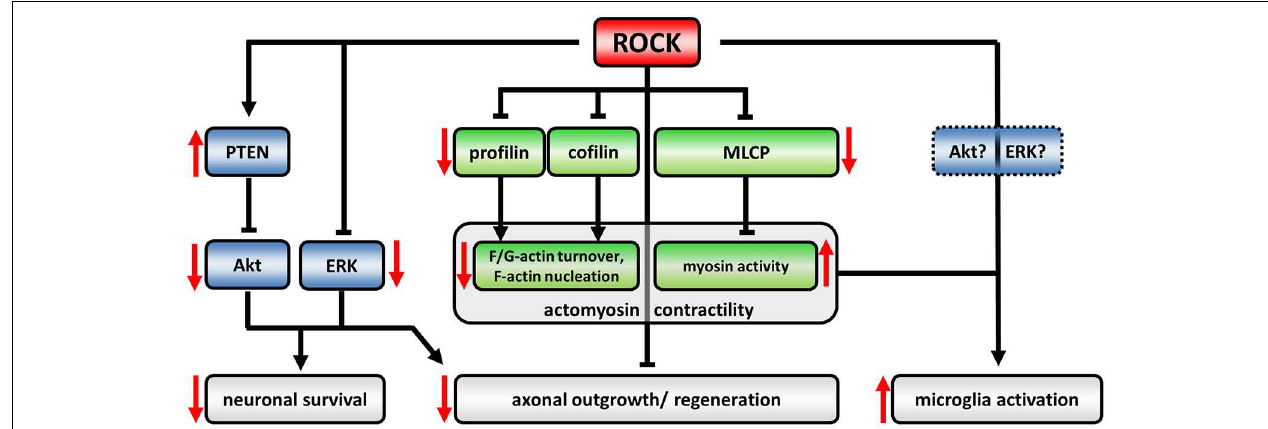
FIGURE 1 | The ROCK-pathway in neurons and microglia. The regulatory network downstream of ROCK is defined by activating (arrows) or inactivating (blunted arrows) interactions. Induction of ROCK-activity leads to an up- or down-regulation of downstream targets, respectively (effects of upregulated ROCK-activity represented by red arrows). ROCK controls actomyosin contractility (canonical signaling, green) as well as Akt- and ERK-activity (non-canonical crosstalk, blue). ROCK-dependent profilin phosphorylation reduces its recycling capacity for globular (G)-actin leading to decreased turnover between filamentous (F) and G-actin. Cofilin-phosphorylation inactivates its F-actin severing activity resulting in less F-actin nucleation. Phosphorylation and inactivation of myosin light chain phosphatase (MLCP) induces myosin